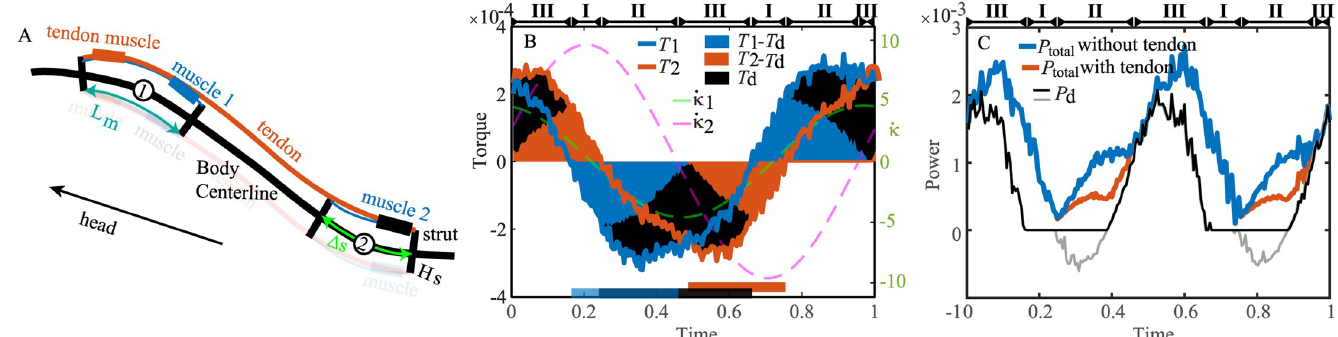
Fig 9. The energy transfer by tendons. (A) Diagram of the tendon model. The muscles and tendon on the left side are drawn as semitransparent for clarity. (B) The torques and time derivative of curvatures as a function of time at the two joints and the torque generated by the tendon muscle. The vertical lengths of the shaded regions indicate the magnitudes of the respective torques. The bars at the bottom indicate the predicted muscle activation periods when the tendons are used. The blue and black bars combined predict the muscle activation at joint 1, and the red bar predicts the muscle activation at joint 2. (C) The total power generated by the muscles with and without the tendons and the power from the tendon muscle. The gray lines indicate the negative power on the tendon muscle but is counted as 0 in computing P total . The stage indices are labeled at the tops of (B) and